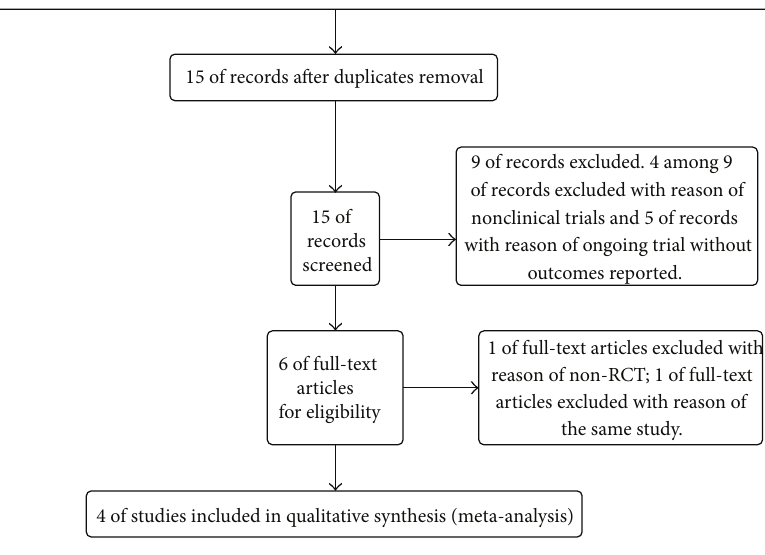
Figure 1: Search study flow diagram.